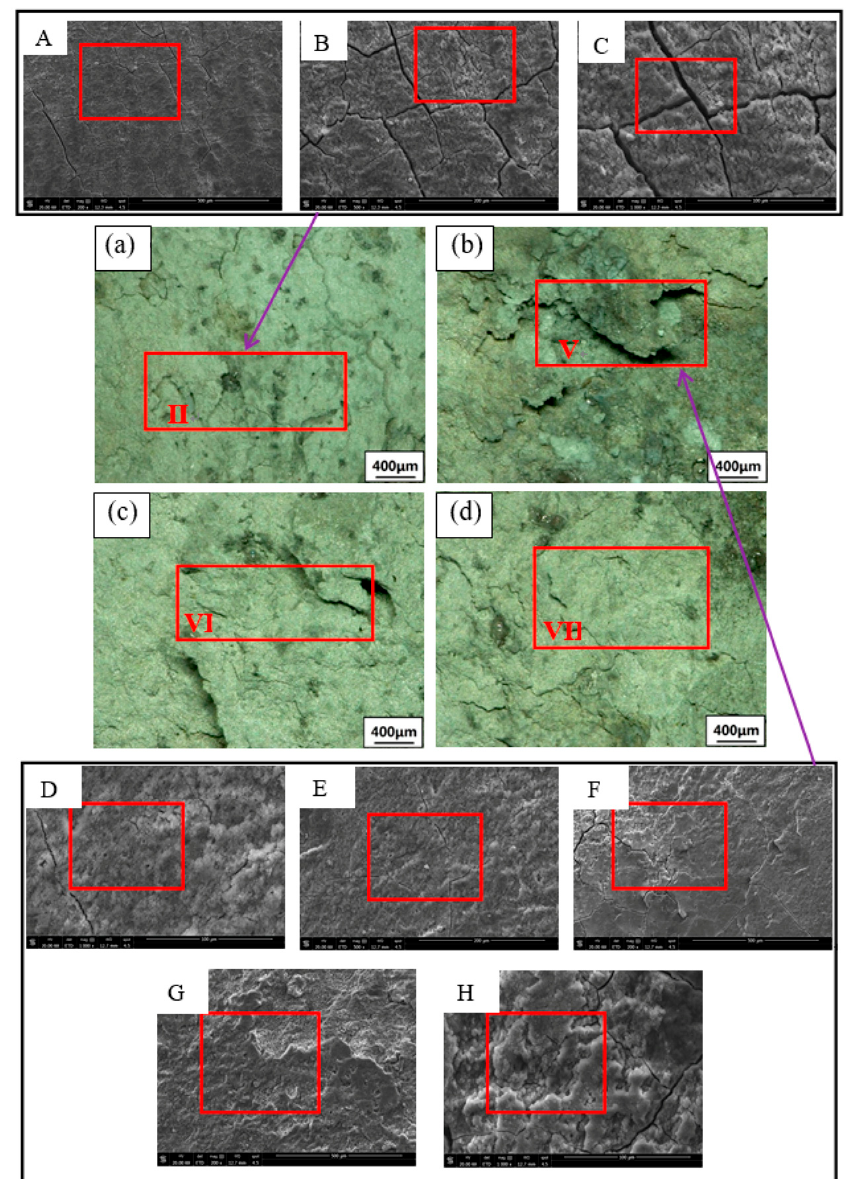
Figure 11. Corrosion morphology of the 2024 FSWed joints with different deformations after 96 h ( a ) 0%, ( b ) 4%, ( c ) 7%, ( d ) 10%, A is pitting corrosion in 0% sample, B is bubbles in 0% sample, C is cracking in 0% sample, D is pitting corrosion in 4% sample, E is bubbles in 4% sample, F is cracking in 4% sample, G is delamination in 4% sample, H is spalling in 4%